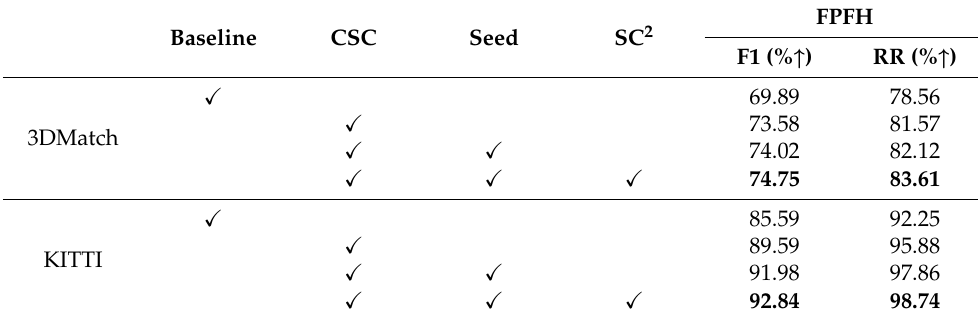
Table 6. Ablation study of the CSCE-Net blocks on 3DMatch and KITTI datasets. Baseline: PointDSC [15]. CSC: Channel-Spatial Contextual block. Seed: The advanced Seed Selection mecha- nism. SC 2 : Second Order Spatial Compatibility (SC 2 ) measure. The test results are combined with the FPFH descriptor.